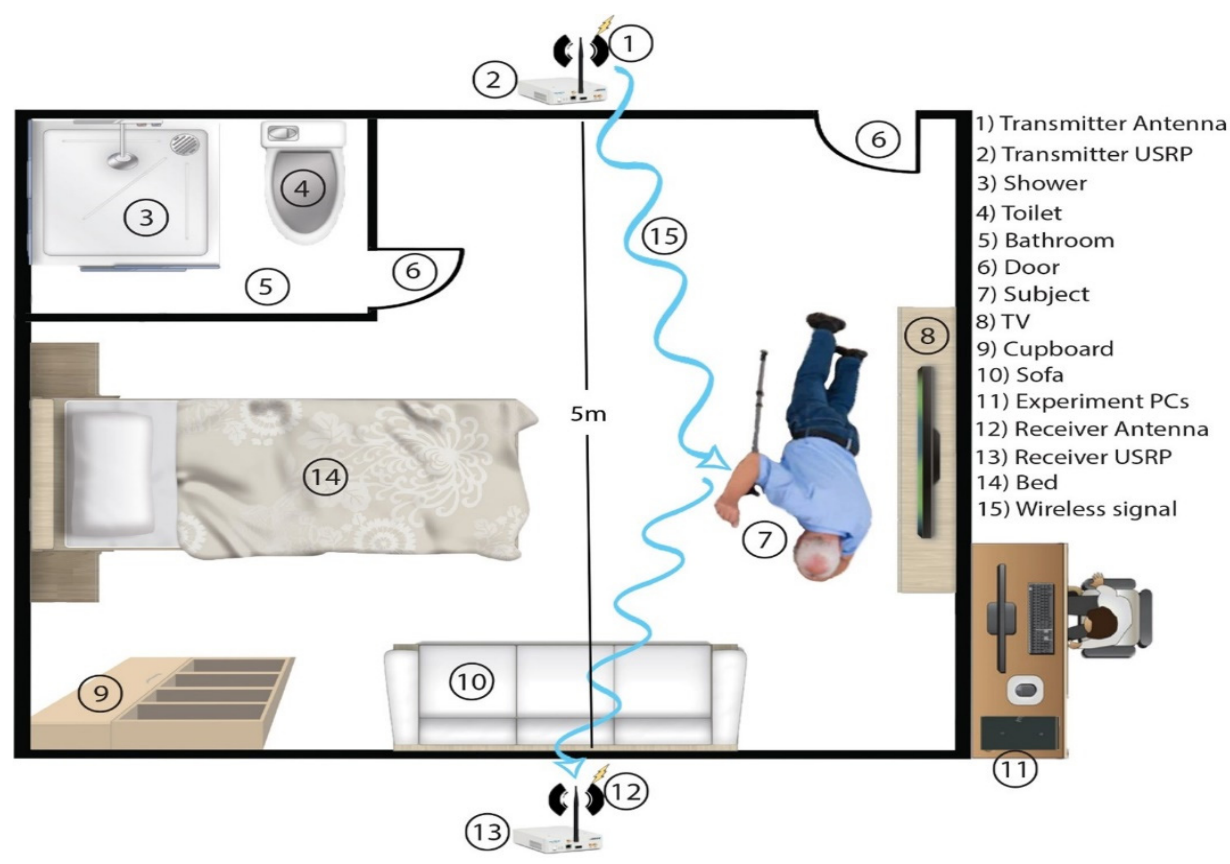
Figure 2. Experimental setup for collecting WCSI data using SDR